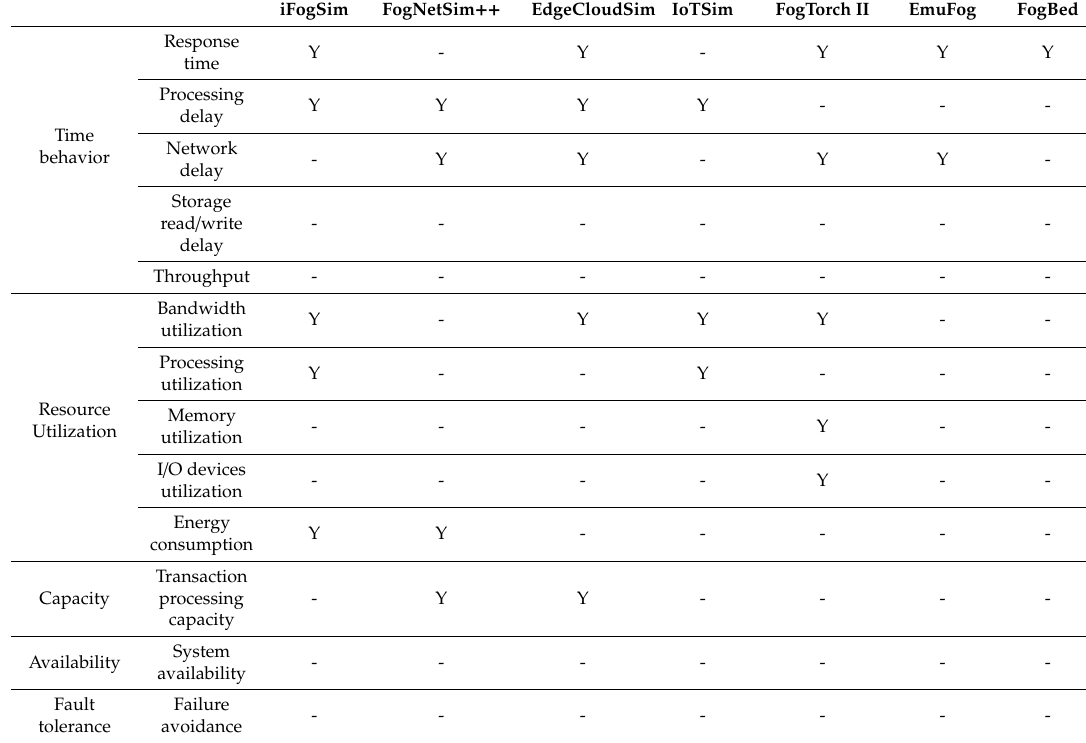
Table 1. Supported qualities and metrics by edge computing